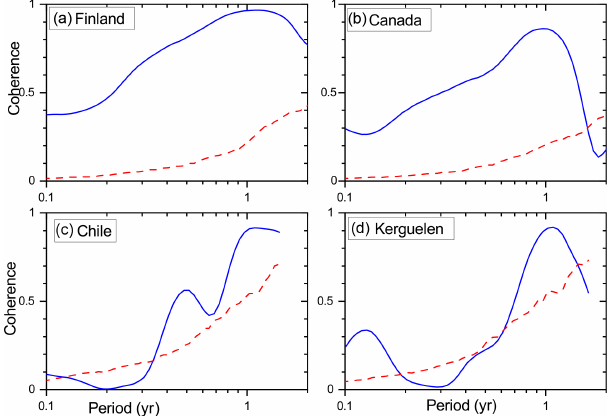
Figure 10. Global wavelet coherence (Morlet base, k = 3) between modeled and measured 7 Be activity for the four locations consid- ered here. The red dashed line denotes the 95% confidence level against the AR(1) red